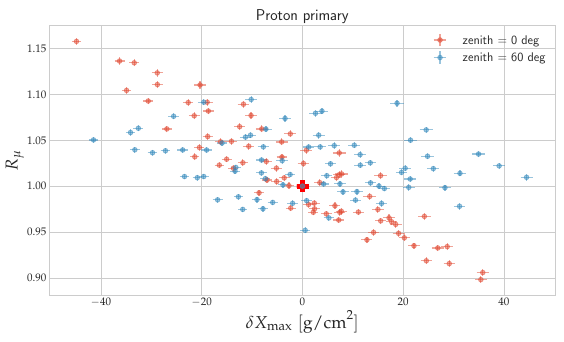
Figure 1. Results of simulations in [ δ X max , R µ ], proton primary.